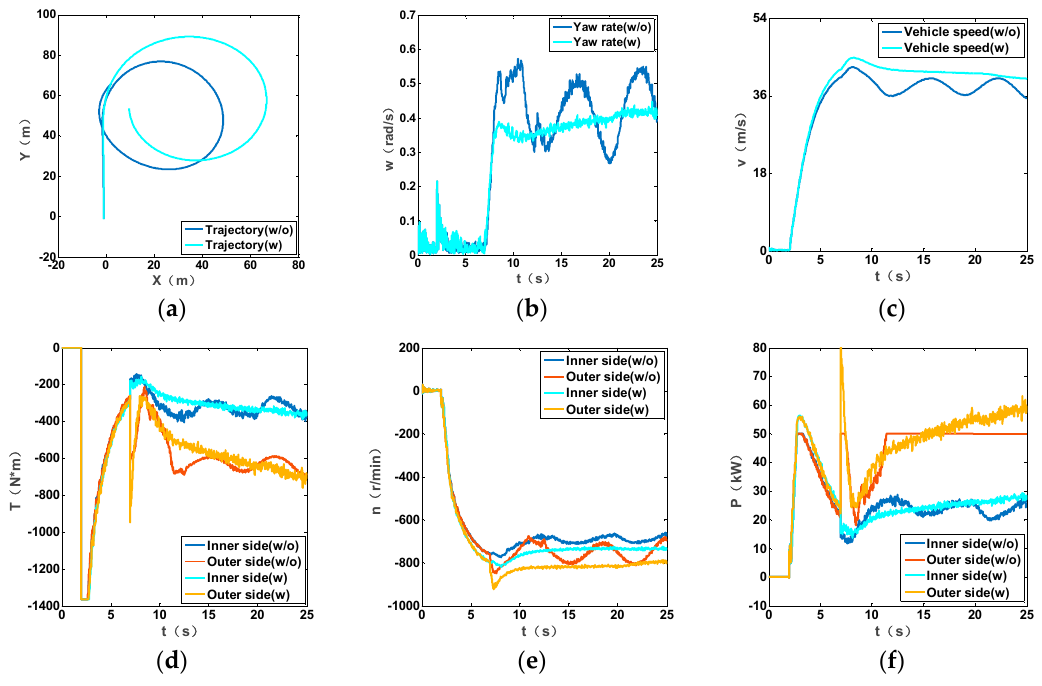
Figure 9. Simulation results of 5 B steering: ( a ) Trajectory; ( b ) Vehicle yaw rate; ( c ) Vehicle speed; ( d ) Sprocket torque; ( e ) Sprocket rotation speed; ( f ) Sprocket power.